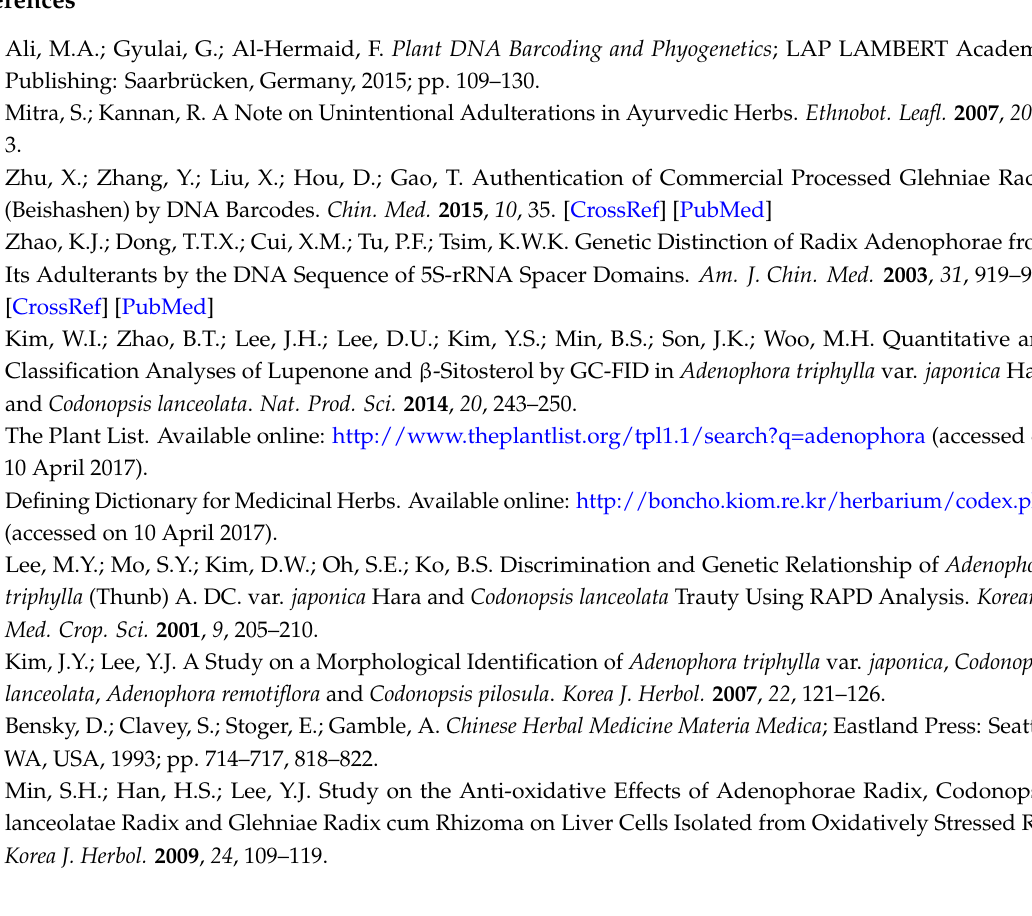
Figure S1, Comparative analysis of nrDNA-ITS sequences used in this study; Data S1: FASTA file of nucleotide sequences of nrDNA-ITS used in this study; Figure S2: Phylogenetic relationships of medicinal plant species based on the nrDNA-ITS